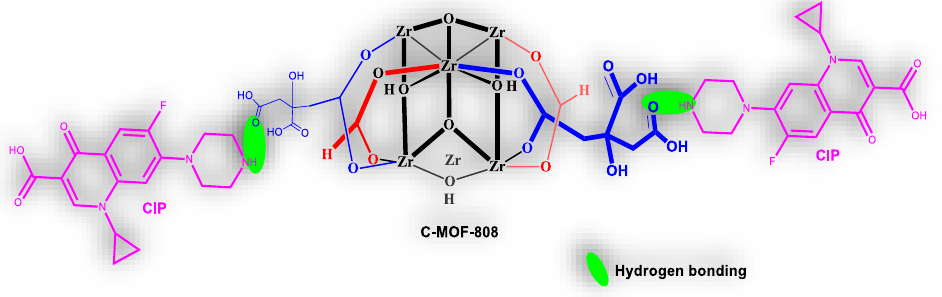
Figure 10. The schematic representation of the proposed mechanism of binding of CIP with the